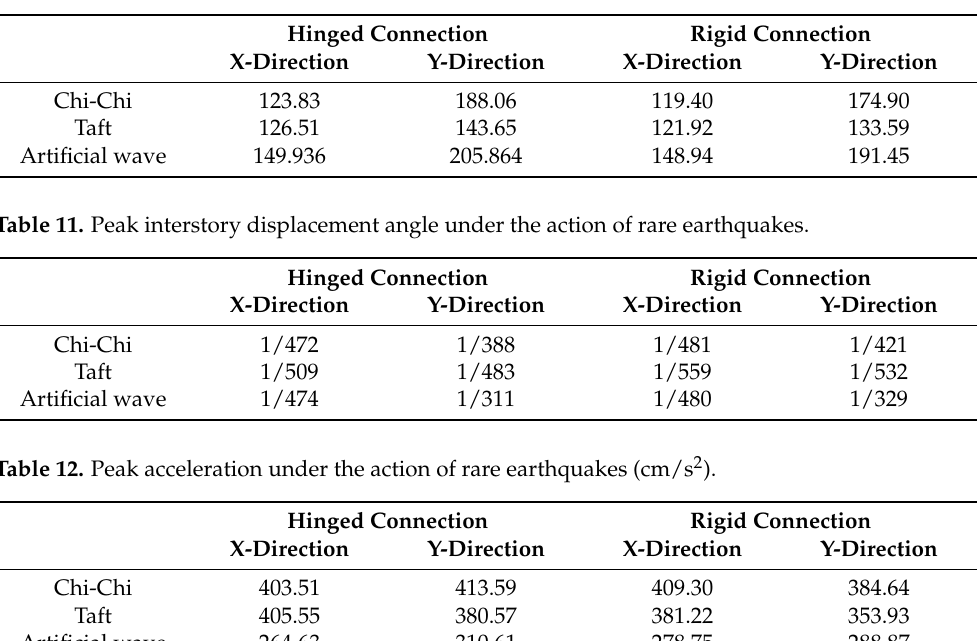
Table 10. Peak displacement under the action of rare earthquakes (mm).